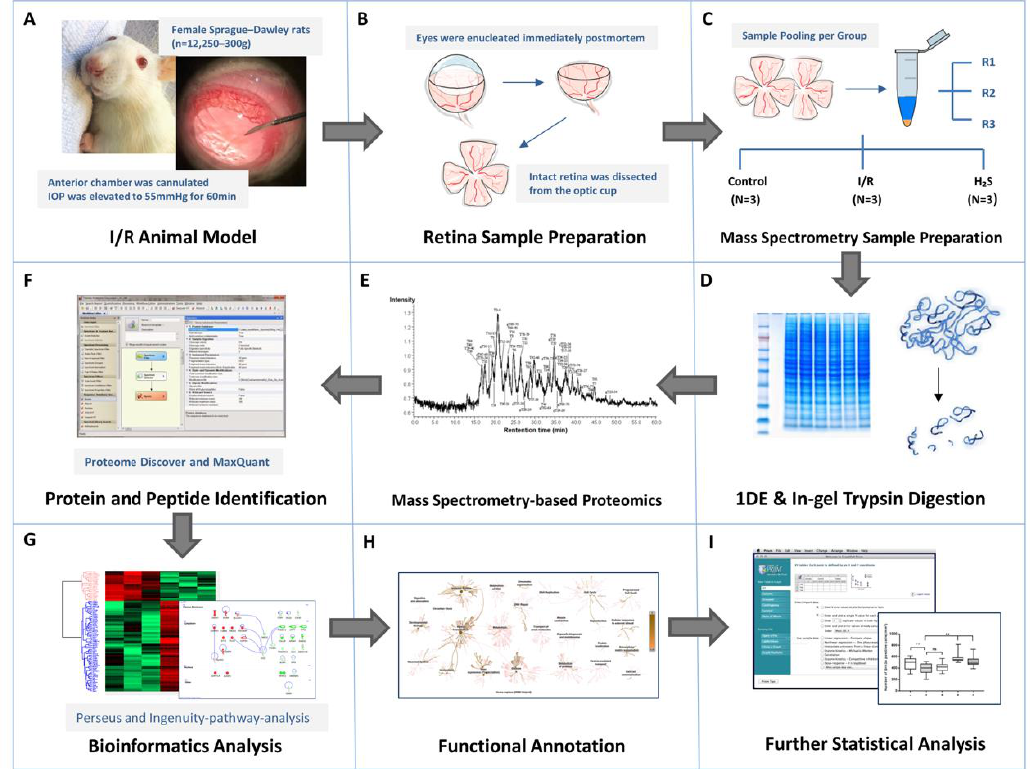
Figure 8. Workflow overview. ( A ) I/R injury was induced in the left eyes of adult female Sprague-Dawley rats ( n = 12), six of which received intravitreal injection of GYY4137, an H 2 S slow-releasing precursor, shortly before intervention. ( B ) Animals were executed 24 h after intervention, retinae were harvested immediately postmortem. ( C – E ) Retinae from contralateral eyes were designated as controls. Retinal samples were immediately weighed and lysed by T-PER tissue protein extraction reagent and Bullet Blender Storm. Six retinal protein samples from respective groups were pooled equally into three biological replicates after protein measurements, represented by RI, R2 and R3 ( N = 3 replicates per group), and subsequently subjected to PAGE. The protein bands were sliced and digested by trypsin prior to proteomic analysis by LC-ESI-MS/MS. ( F – H ) The emerging datasets were subjected to robust bioinformatics analyses and functional annotations to identify the differential protein expressions and protein interaction networks. ( I ) To confirm the result of I/R injury and protective effect of H 2 S in retina, one quarter of each retinal sample ( n = 6 per group) were subjected to immunohistochemistry staining against Brn3a for RGC quantification. The averaged RGC density was calculated per mm 2 . Significance of difference between groups was determined by 1-way ANOVA.